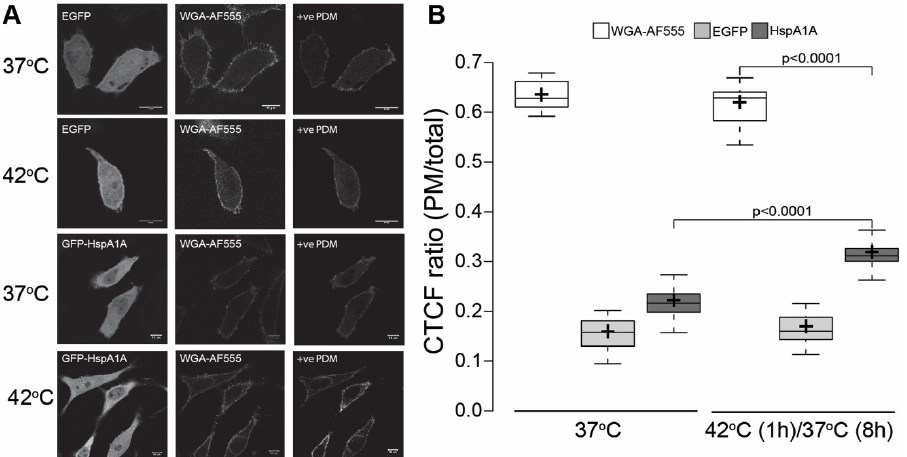
Figure 1. Plasma membrane localization of HspA1A increases during recovery from mild heat-shock at 42°C. (A) Representative images of Henrietta Lacks’ ‘Immortal’ (HeLa) cells expressing empty EGFP or GFP-HspA1A. The cells were grown under normal conditions (37°C) or heat-shocked for 1